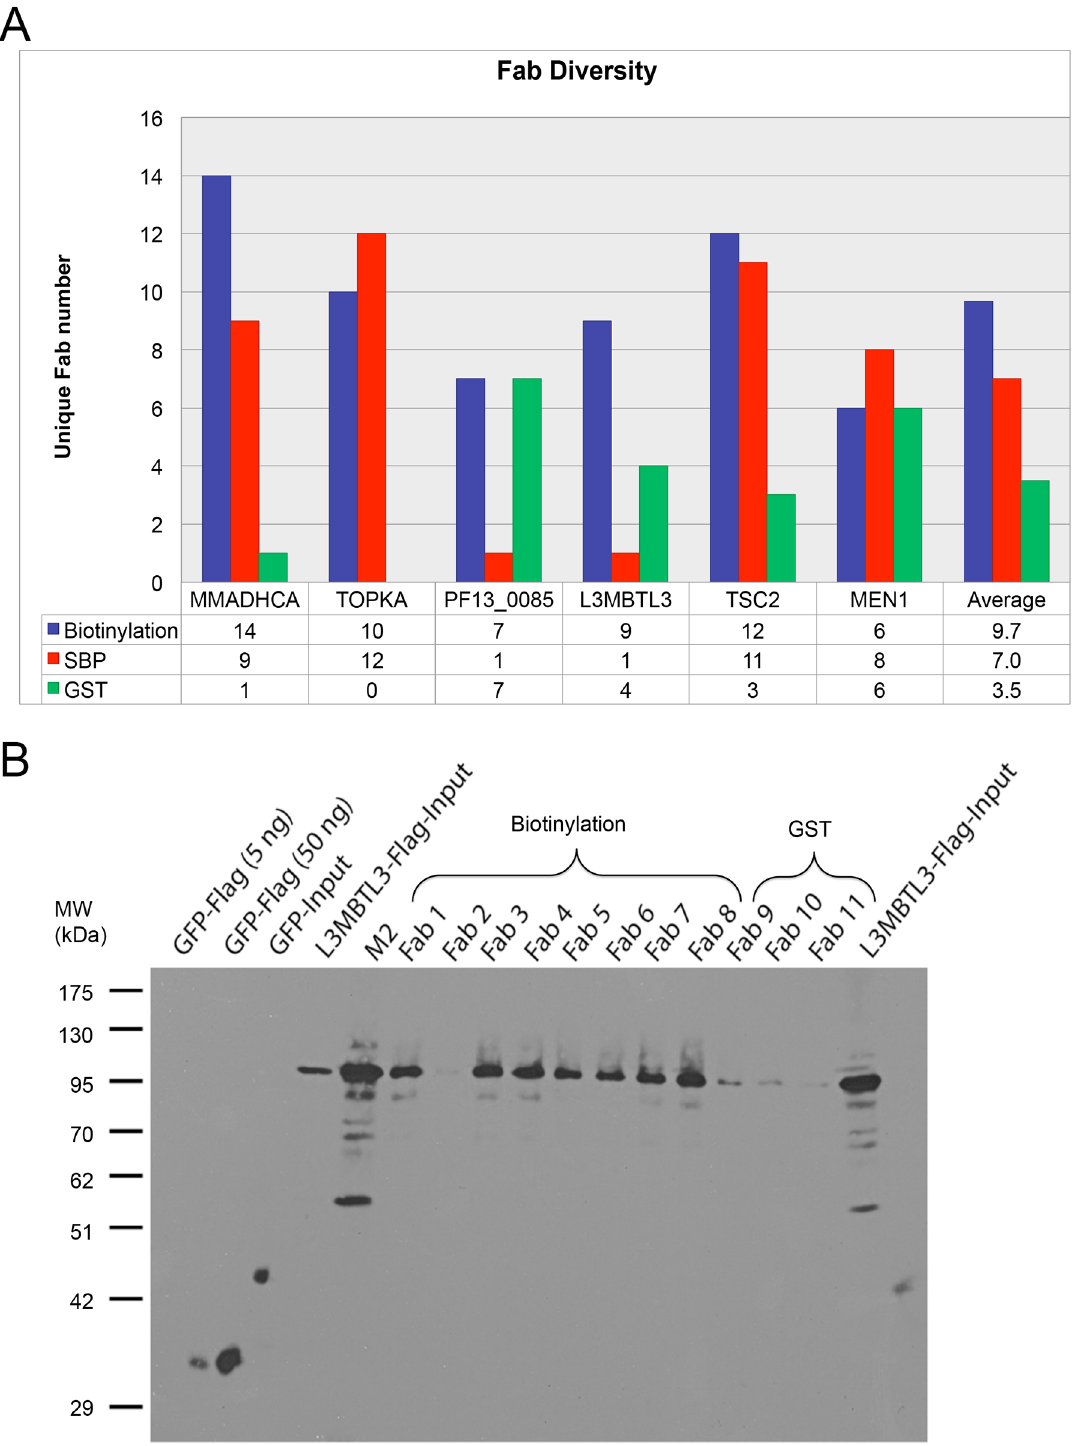
Fig 1. Comparison of antigen immobilization methods. (A) Three different affinity tags were tested for antigen immobilization in phage display; in vivo biotinylation through an Avi tag, SBP and GST tags. The diversity of Fabs derived from these differentially tagged antigens was then compared. (B) Immunoprecipitation with Fabs selected against either Avi-tagged antigen or GST-tagged antigen from a cell lysate expressing FLAG-tagged target protein. Immunoprecipitated antigen was detected with an M2 antibody against the FLAG tag. Fabs selected against Avi-tagged antigen generally show a higher recovery of the